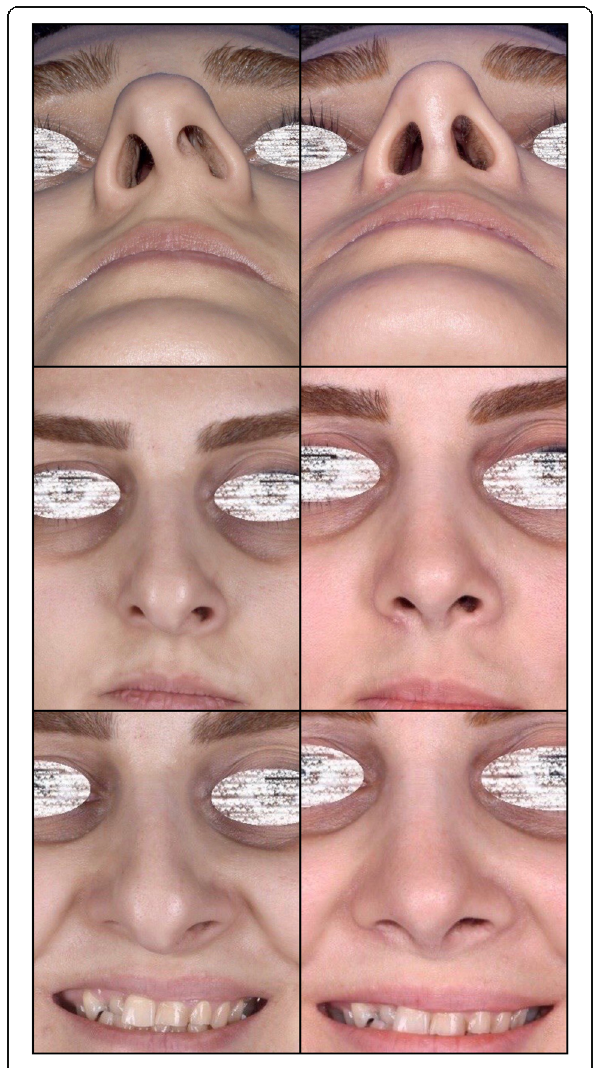
Fig. 7 Patient who underwent rhinoplasty with sill graft. The figure shows preoperative and postoperative views from lateral aspect ( a , b ) and basal aspect ( c , d ). b , d Postoperative